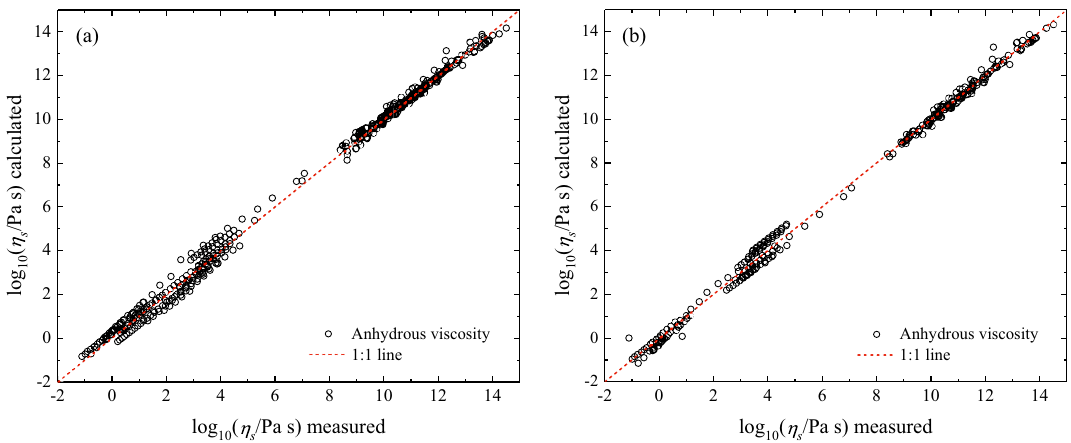
Figure 3. Predictions of anhydrous viscosity used for model calibration. ( a ) Comparison between anhydrous viscosity data ( N dry = 441) from the literature and MYEGA predictions (Eq. 1, where η ∞ = 10 −2.93 Pa s) using the melt fragility m derived by Brillouin data (Table 2) m via Eq. (6). ( b ) Comparison between anhydrous viscosity data ( N dry = 288) from the literature and the model predictions (Eq. 1) using the melt fragility m derived by ω BP via Eq.